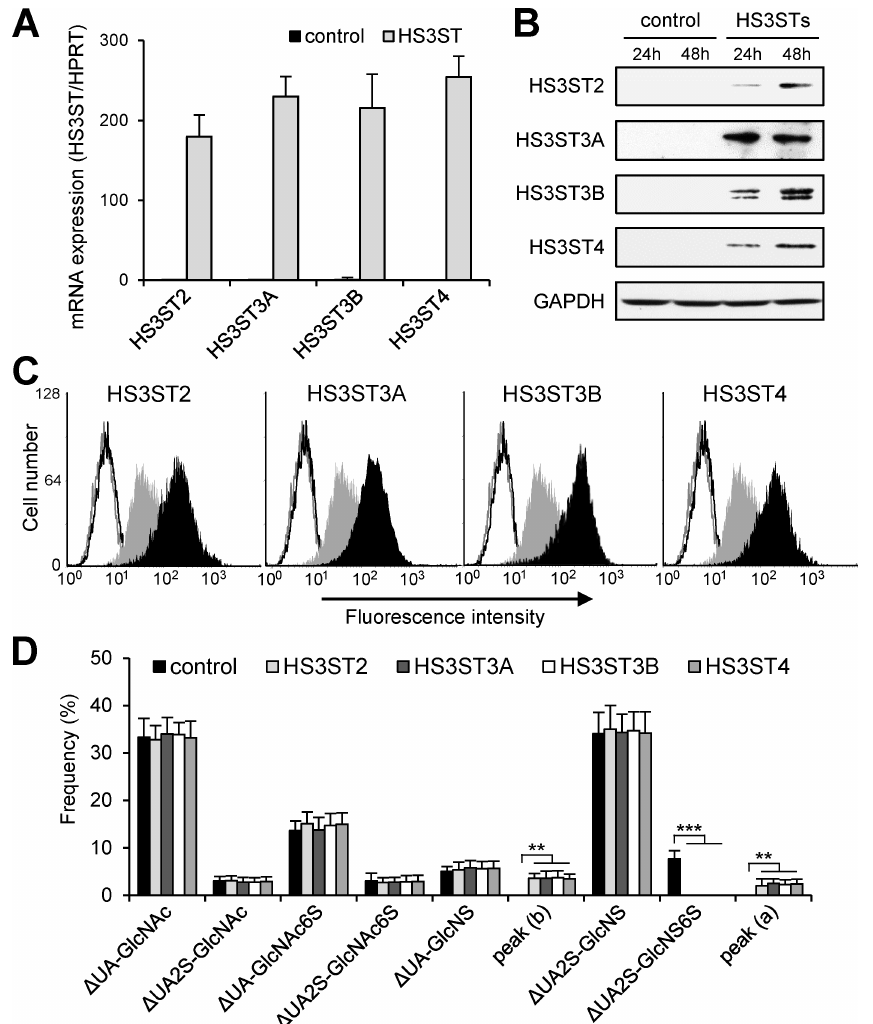
Fig 1. Overexpression of gD-type HS3STs in MDA-MB-231 cells. Cells were transiently transfected with empty vector (control) or vectors encoding HS3ST2, HS3ST3A, HS3ST3B or HS3ST4, and then cultured for 24 h and 48 h prior analysis of the expression and activity of each isozyme. ( A ) Following RNA extraction, the mRNA levels of HS3STs were quantified by real-time RT-PCR at 24 h post-transfection. Relative abundance of the transcripts was normalized to endogenous HPRT mRNA. Data are means ± SD from at least three distinct experiments. ( B ) In parallel experiments, proteins from cell lysates were separated by SDS-PAGE and subjected to Western blotting with appropriate specific antibodies. Parallel immunoblotting with antibodies to GAPDH confirmed equal loading of the samples. ( C ) Efficiency in the reaction of heparan 3- O -sulfation was confirmed 48 h post-transfection by using HS4C3 antibody. Cell surface fluorescent staining was detected by flow cytometry. Filled histograms represent the staining obtained with HS4C3 antibody, while open histograms correspond to the binding of the irrelevant antibody MBP49. Each panel represents the binding of the antibodies to the surface of HS3ST-expressing cells (black histograms) compared to the binding of the same antibodies to control cells (grey histograms). Data are representative of three separate experiments. ( D ) Compositional disaccharide analysis of HS from transfected MDA-MB-231 cells. Following depolymerization of HS with a mixture of heparinases, disaccharides were labelled with AMAC and resolved by RP-HPLC (see S1 Fig). Data are expressed as frequency of each disaccharide and correspond to means ± S.D. from two sets of triplicate injections performed with distinct cell preparations ( (cid:3)(cid:3) P < 0.01, (cid:3)(cid:3)(cid:3) P < 0.001, significantly different when compared to control